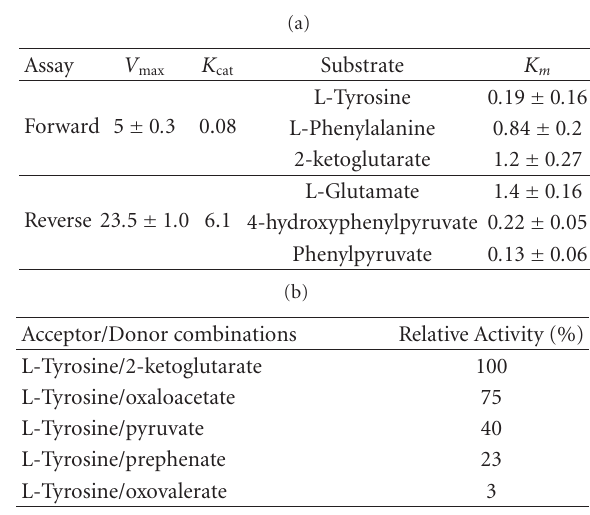
Table 2: (a) Kinetic properties of At5g36160. The enzyme assays used to determine the kinetic parameters are described in Section 2. μ molesmin − 1 mg − 1 of protein, K V m of max is represented in the various substrates is represented in millimolar (mM), and K − 1 . The measurements were made under cat is represented in S optimal conditions with respect to pH, temperature, and substrate concentrations (supplementary material). The kinetic constants were calculated by nonlinear regression analysis using the GraphPad Prism Version 3.03 software. (b) Relative substrate specificity of At5g36160 with various amino acceptors. The assay measured the production of 4-hydroxyphenylpyruvate at 331 nm using 10mM amino donor (L-Tyrosine) and 10mM amino